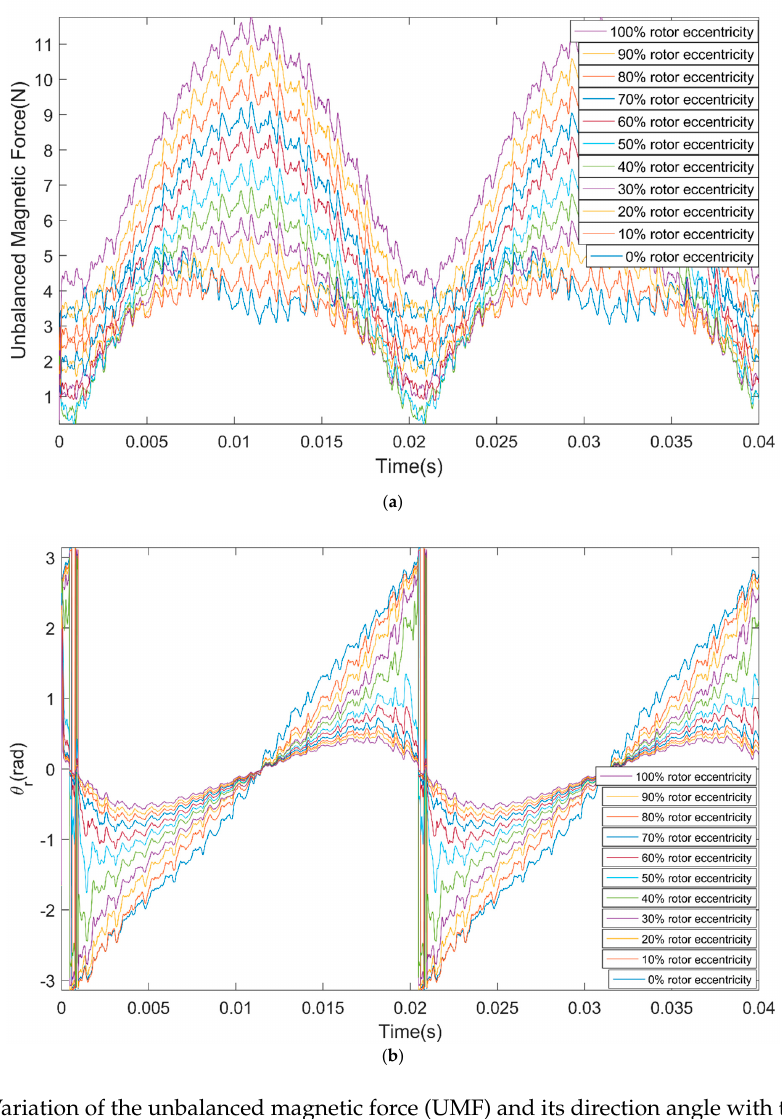
Figure 6. Variation of the unbalanced magnetic force (UMF) and its direction angle with time under different rotor eccentricity. ( a ) UMF; ( b ) direction angle of the UMF θ r . Micromachines 2020 , 11 , x